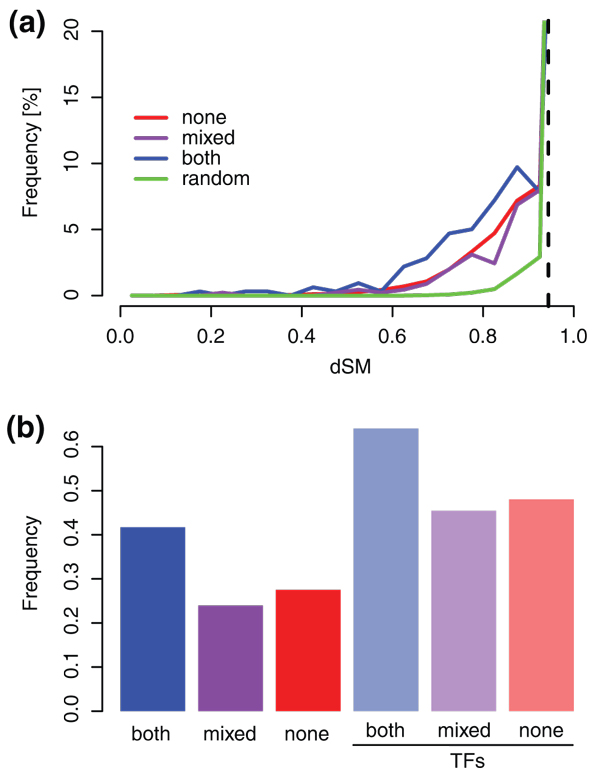
Conservation of upstream regulatory regions as measured by dSM. (a) Distribution of dSM scores between all paralogous pairs, according to H3K27me3. The dashed vertical line shows the dSM value at the fifth percentile of the random pairs (0.94). (b) Frequency of paralogous pairs with dSM lower than the fifth percentile cutoff.